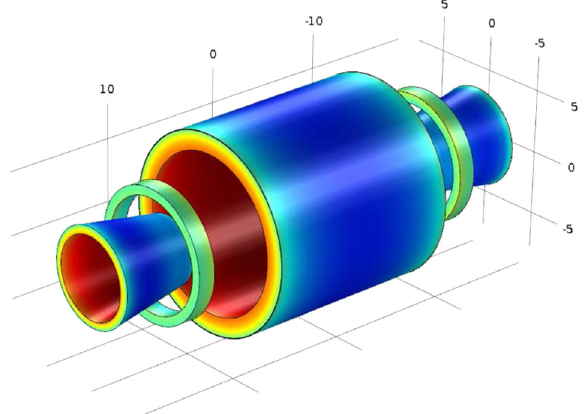
FIG. 11. Three-dimensional representation of the unshielded solenoid in combination with two balanced forward solenoids. The color indicates the field on the surface of the cold mass (see the legend in Fig.